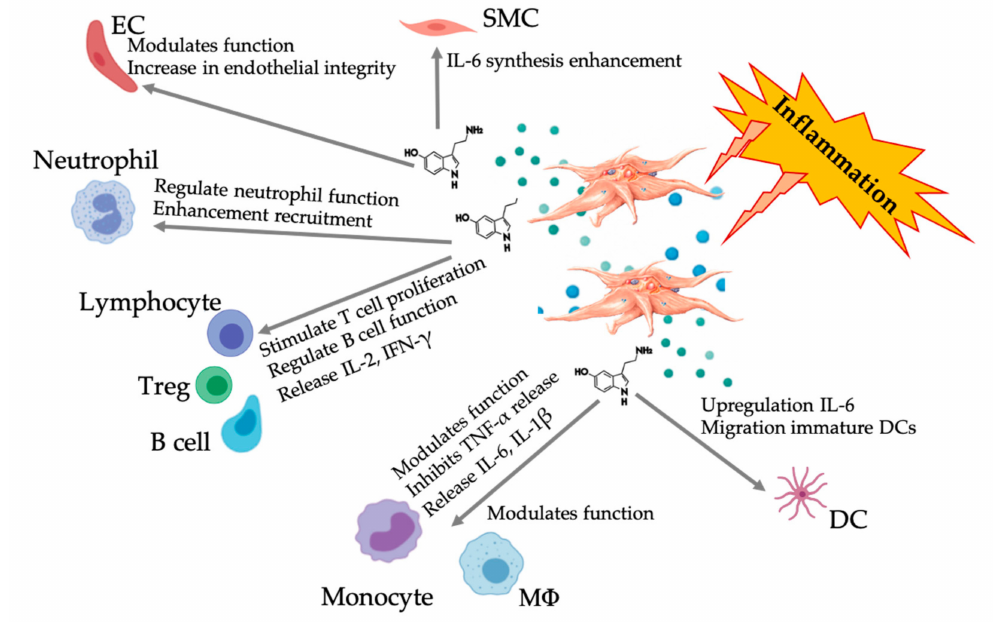
Figure 5. Illustration of the multifaceted 5-HT responses following inflammatory PRP-platelet activation. After platelet activation, platelets release their granules, including 5-HT from dense granules, inciting a wide range of di ff erential e ff ects on various immune, endothelial, and smooth muscle cells. Abbreviations: SMC: smooth muscle cell, EC: endothelial cell, Treg: regular T lymphocyte, M Φ : macrophage, DC: dendritic cell, IL: interleukin, IFN- γ : interferon gamma. Modified and